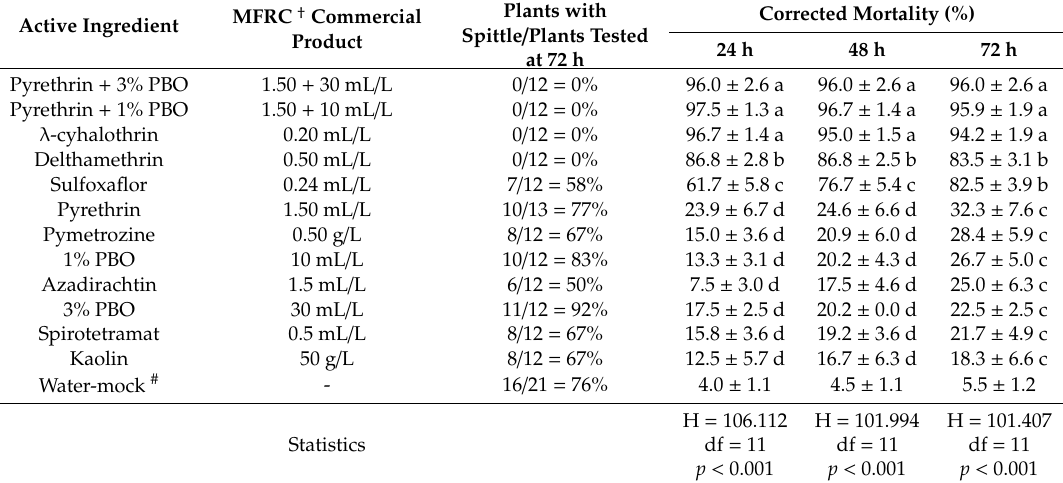
Table 3. Laboratory experiments. Lethal e ff ect of pesticides on P. spumarius nymphs (mean ± SE) after 24, 48 and 72 h-exposure to the insecticides on S. oleraceous plants and spittle formation at 72 h. Di ff erent letters within the same column indicate statistical di ff erences according to Kruskal–Wallis H test ( p ≤